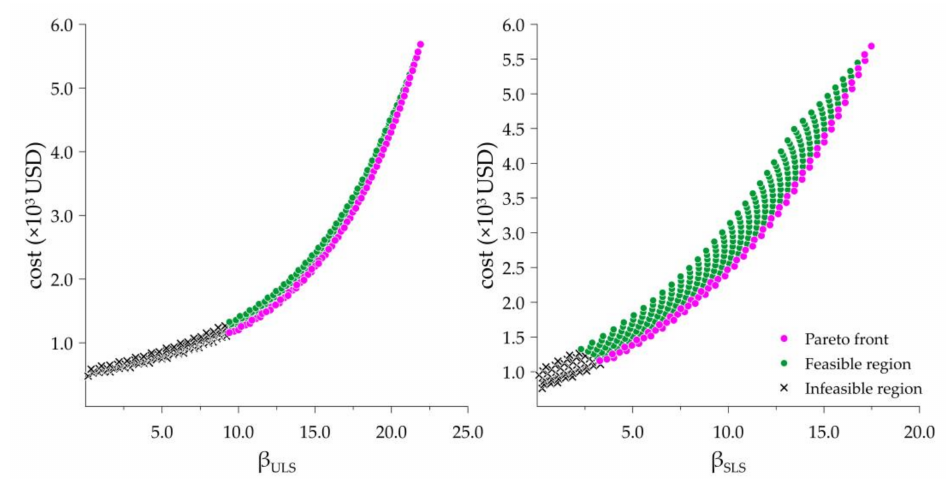
Figure 11. The projections of the Pareto front, the dominated and infeasible designs onto planes β ULS − cost and β SLS − cost